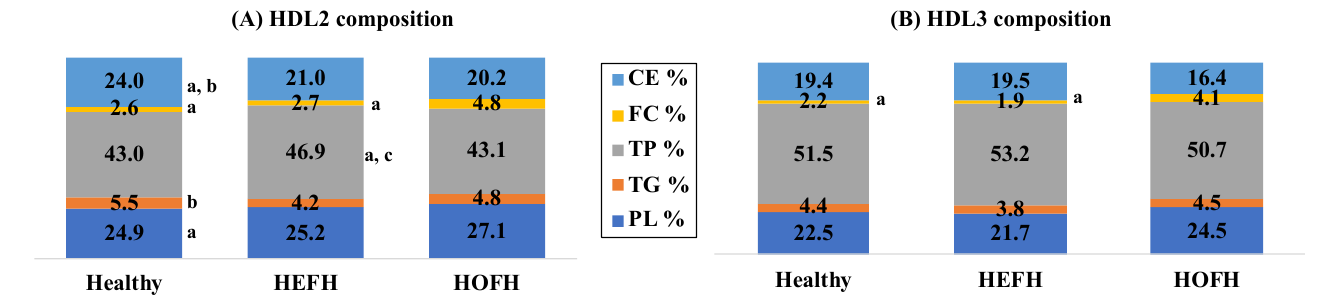
Figure 1. Comparison of wt% lipid and protein content of HDL subtraction between the groups; a: p < 0.05 vs HOFH; b: p < 0.05 vs HEFH; c: p < 0.05 vs controls. CE: cholesterol ester; FC: free choles- terol; PL: phospholipid; TG: triglyceride; TP: total protein.